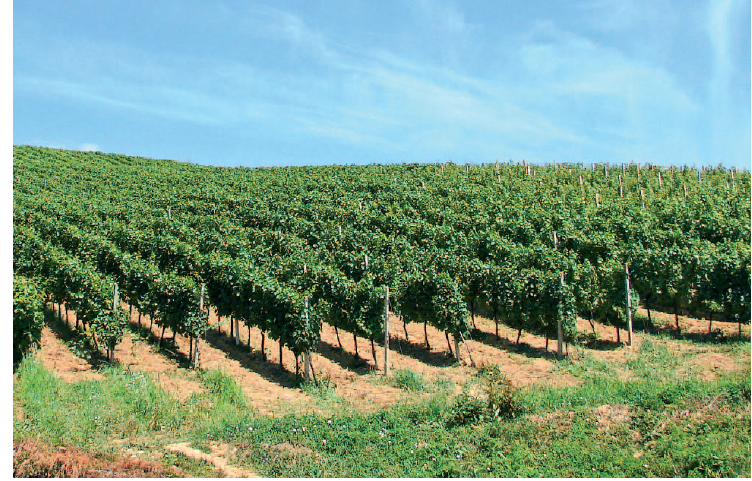
Figure 4. Morphological uniformity of individual vines in terms of height and width.